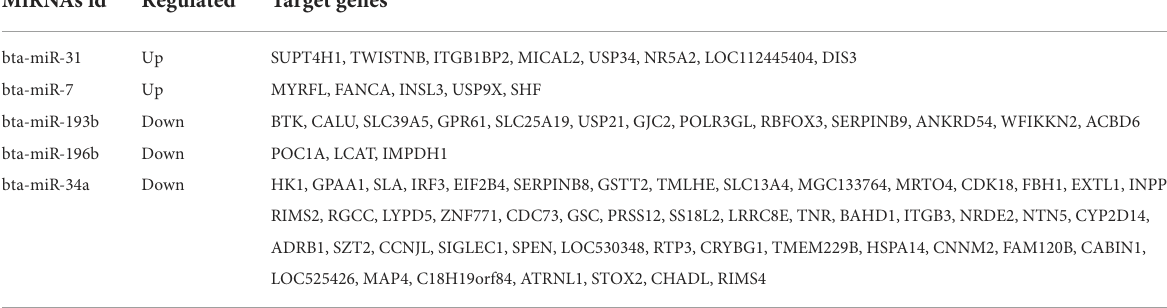
TABLE 4 The list of differentially expressed miRNAs and their target genes of M vs. P.